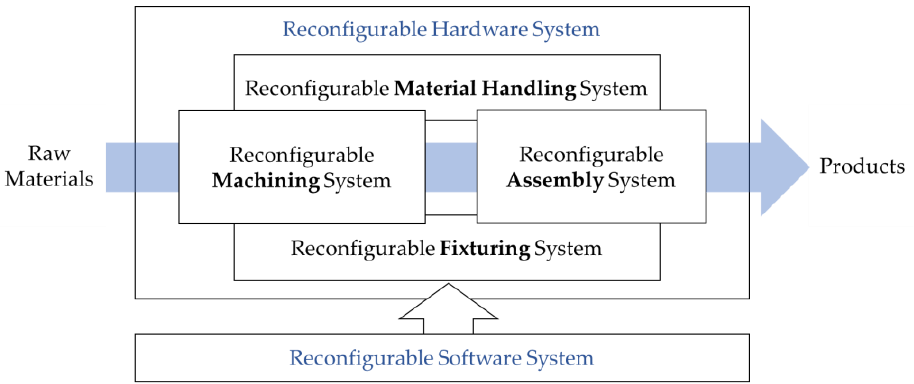
Figure 1. Reconfigurable factors in a reconfigurable manufacturing system (RMS).